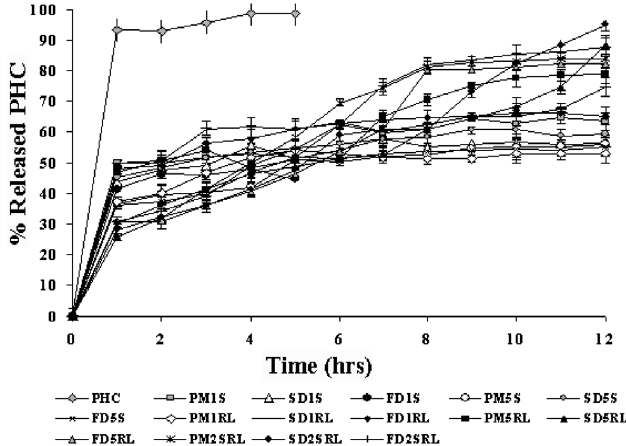
FIGURE 3 - Comparative Dissolution Profiles of PHC and Solid Dispersions in Phosphate buffer pH